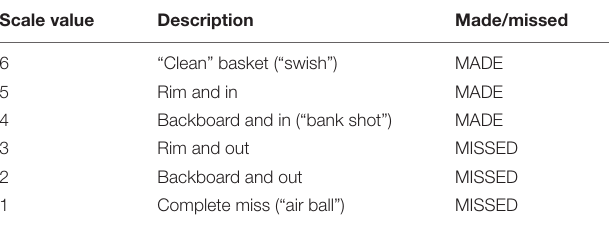
TABLE 1 | Six-point shot quality scale with descriptions of visual